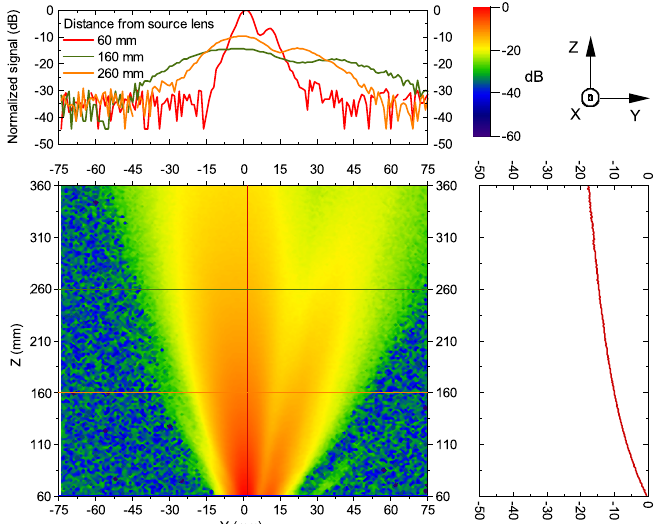
Figure 9. Beam profile of VCO1 in the Y and Z direction, measured with a resonant detector (the setup similar to depicted in Figure 1b, but does not contain the mirror/lens). The data is normalized to the maximum signal. Top: horizontal cross-sections at different distances from the source lens. Right: vertical cross-section at the middle of the THz